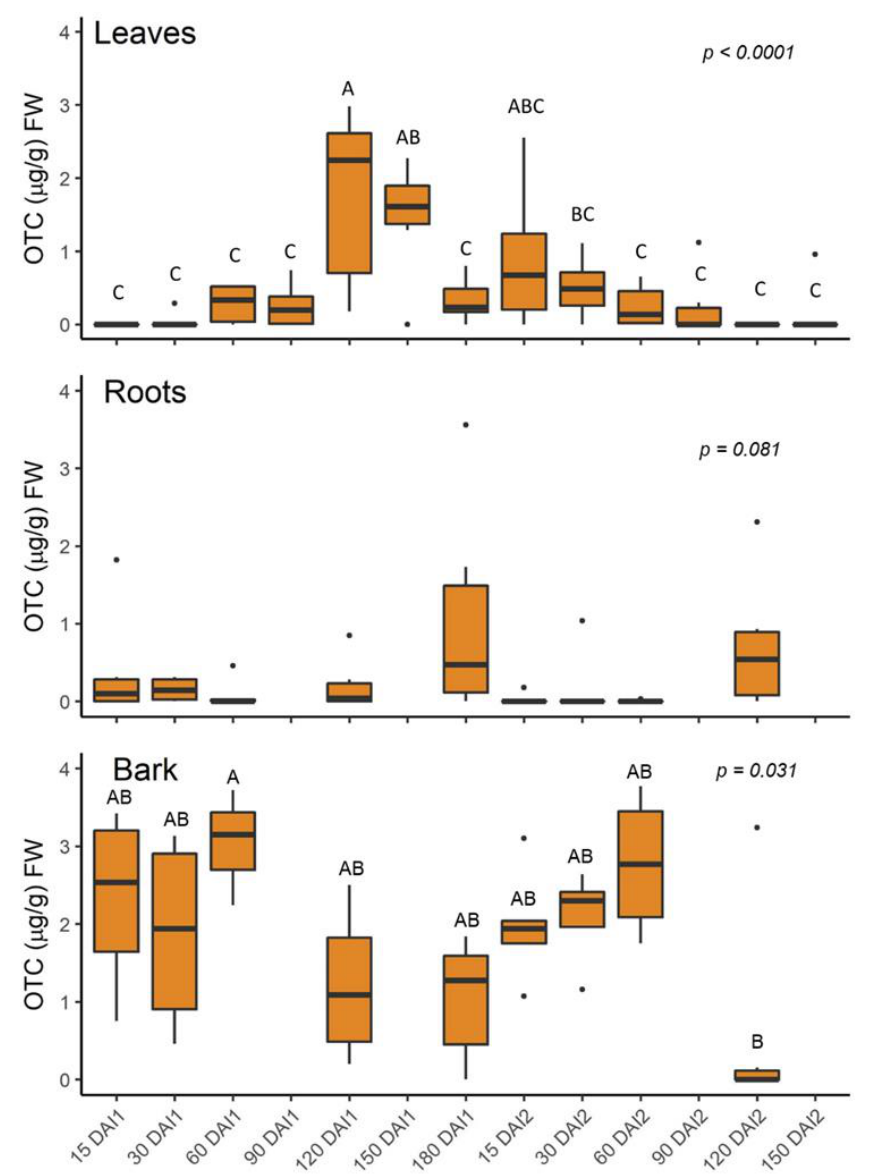
Figure 9. Leaf oxytetracycline (OTC) concentration after injection 1 in October 2020 and injection 2 in April 2021. DAI1 = days after October injection; DAI2 = days after April injection. 180 DAI = 0 DAI2. Different letters indicate significant differences ( p < 0.05) between time points according to Tukey’s honest significant difference test. Letters not shown when differences were not